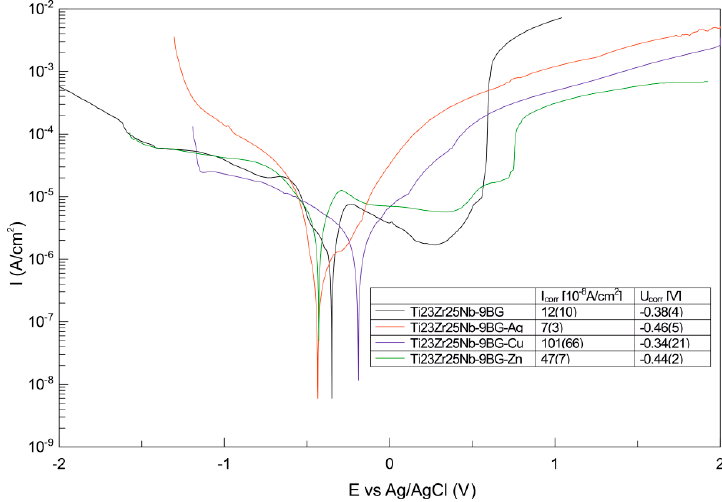
Figure 12. Potentiodynamic curves of bulk Ti23Zr25Nb-based composites with the 9 wt.% 45S5 Bioglass and 1 wt.% Ag, Cu, Zn content in contrast with the Ti23Zr25Nb-9BG composite.